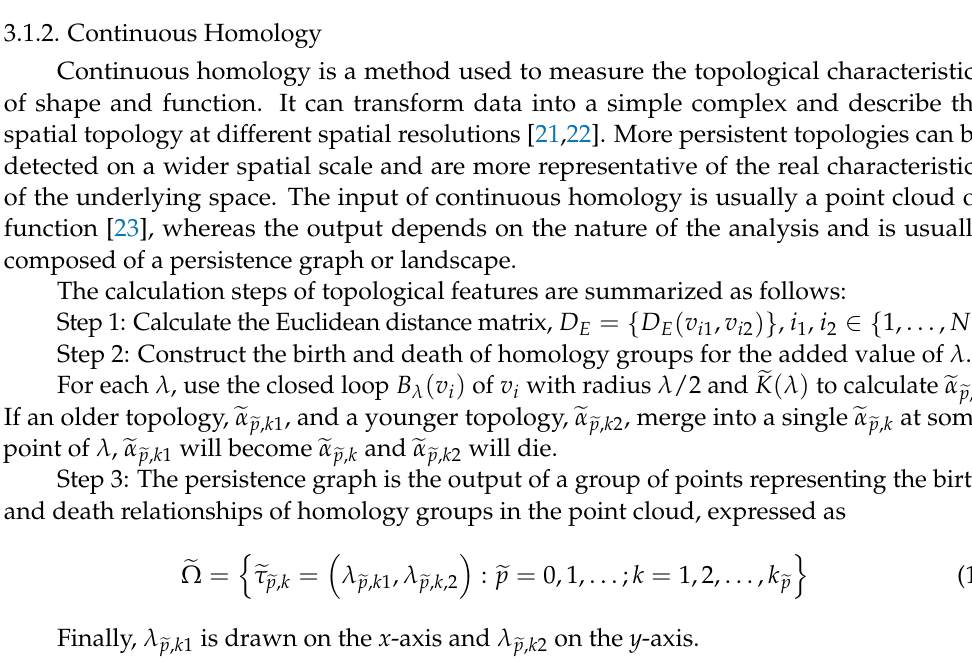
Figure 1. Simple complex diagram.